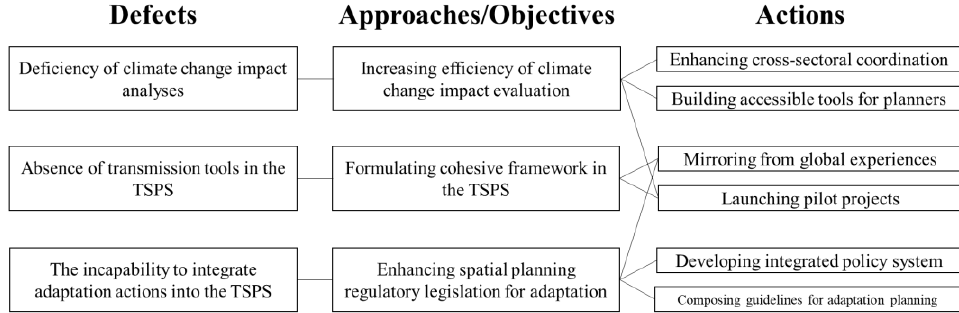
Figure 10. Approach/objective – action